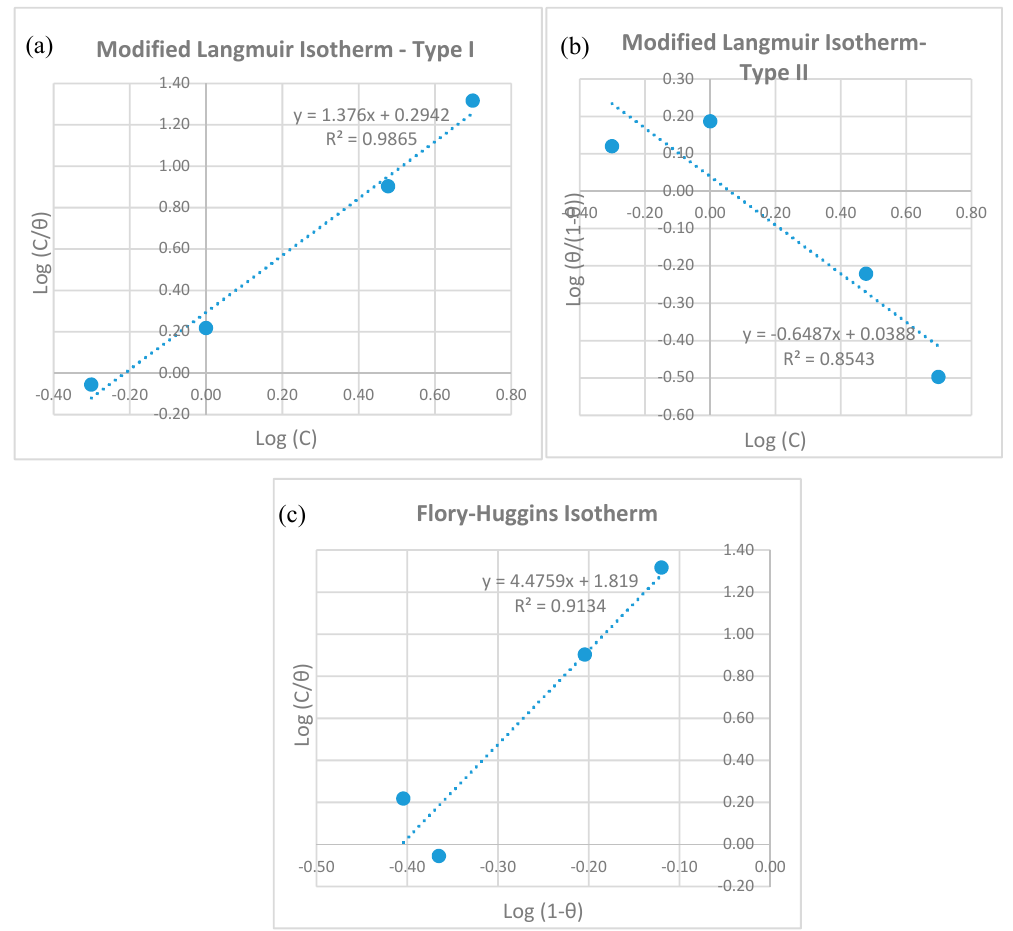
Figure 7. Adsorption isotherm plots for CNTs and gum arabic adsorbed on 316L stainless steel after potentiodynamic testing at 22 °C.